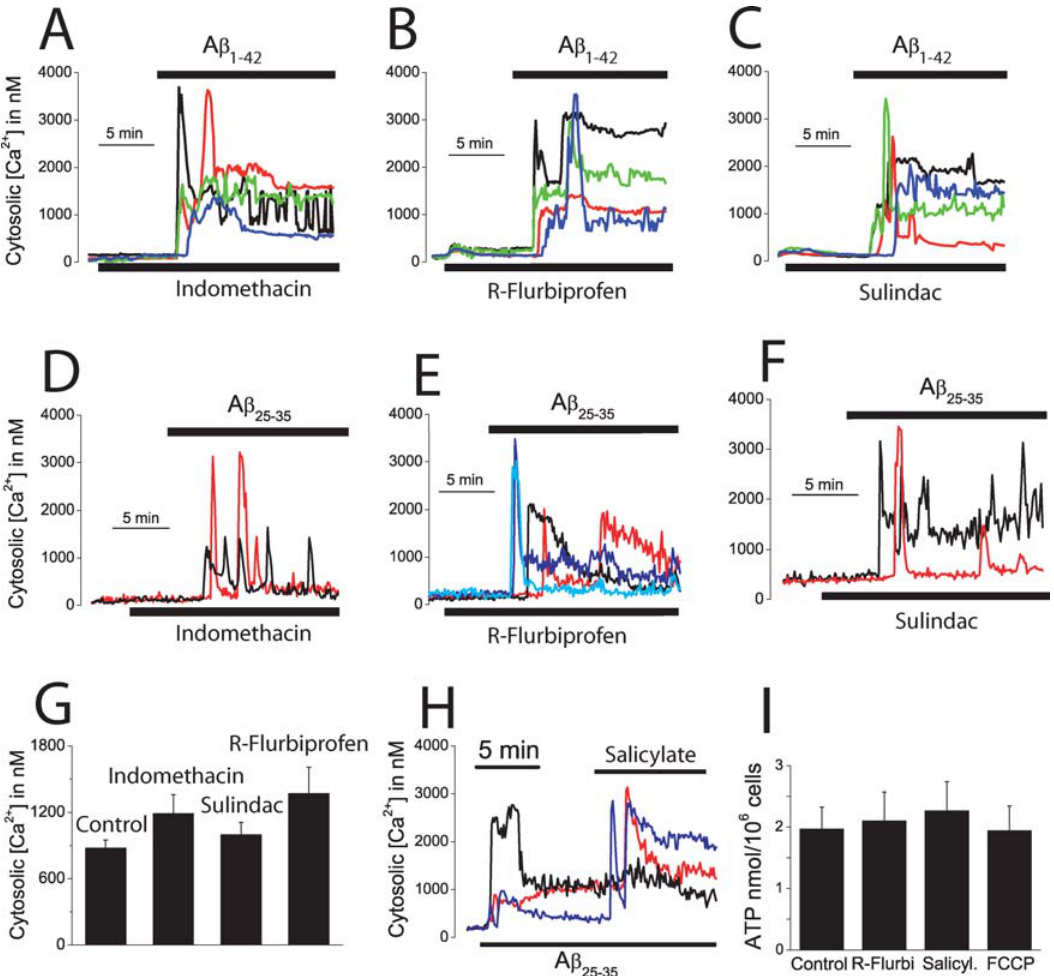
Figure 7. NSAIDs do not prevent the increase in [Ca 2 + ] cyt induced by A b 1–42- oligomers or affect cell ATP levels. A–C , cerebellar granule cells were loaded with fura4F/AM and subjected to calcium imaging to test the effects of several NSAIDs on the increases in [Ca 2 + ] cyt induced by A b 1– 42 oligomers. Neither indomethacin (A), R-flurbiprofen (B) or sulindac sulfide (C), all tested at 1 m M, inhibit the increase in [Ca oligomers. Data corresponds to 76–120 cells, corresponding to at least 2 experiments. D–G, indomethacin, R-flurbiprofen or sulindac sulfide (all